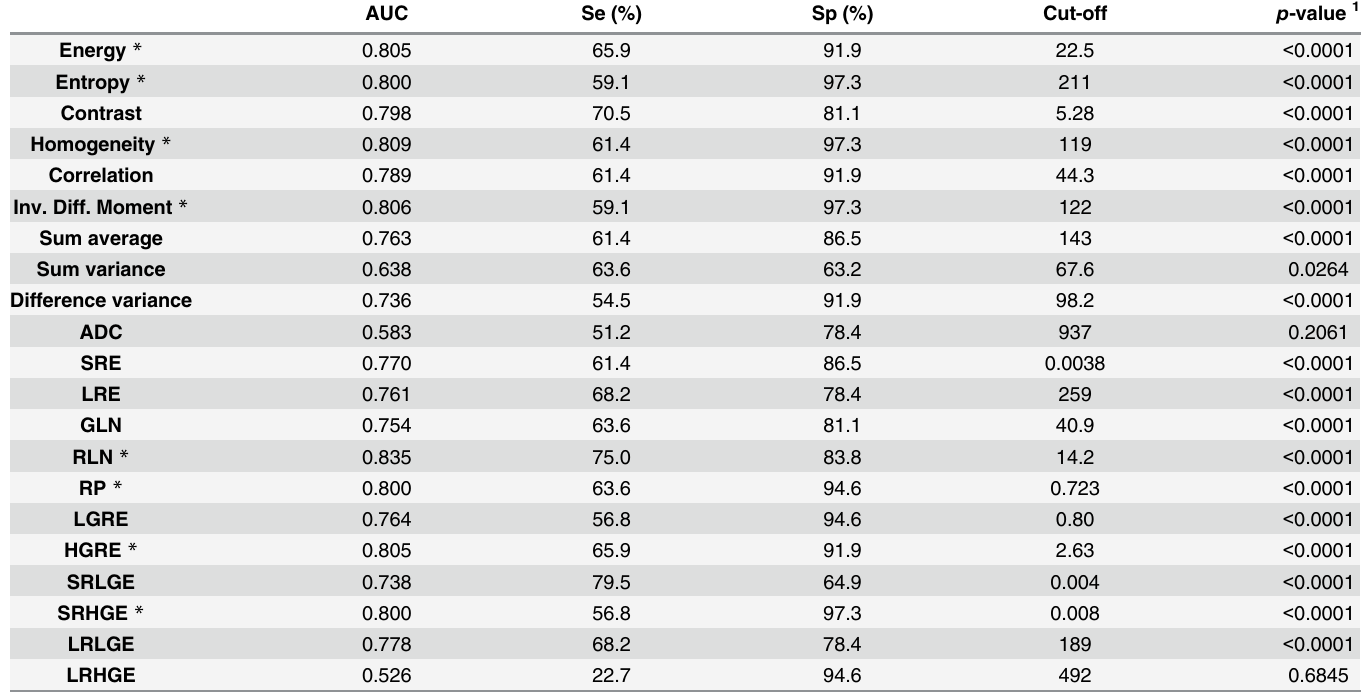
Table 3. Performance of individual parameters in differentiating between enhanced and unenhanced MS lesions assessed by non-parametric receiver operating characteristic (ROC) curves. The significant p -values observed show that individual texture parameters are able to differentiate between the two types of MS lesions. Eight texture parameters displayed a level of individual performance that was at least ‘ good ’ . None of these eight parameters was found to be significantly better performing than the